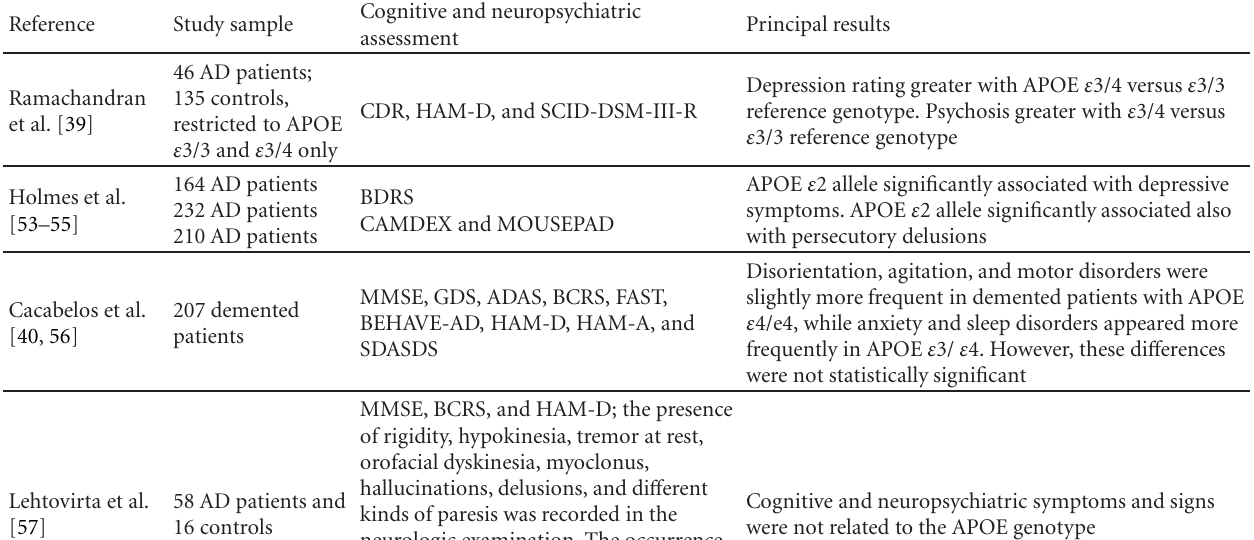
Table 1: Principal studies on the association of neuropsychiatric symptoms, endophenotypes, and syndromes with the apolipoprotein E (APOE) polymorphism in Alzheimer’s disease (AD)